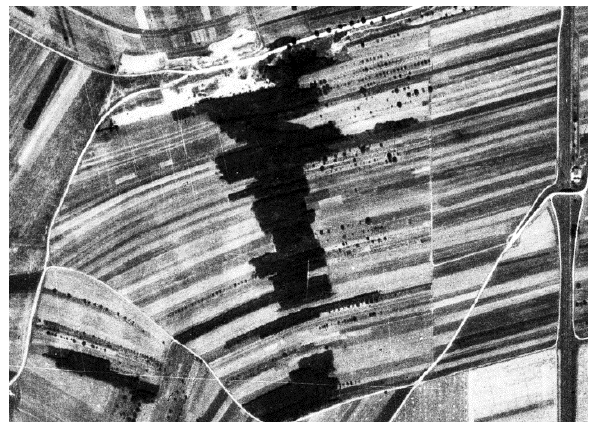
Figure 3. The result of Histogram Equalization The vector data of polygon categories made it possible to measure the total expanse of greenery, the expanse of individual green areas, the perimeter of individual green areas, and the shape of the areas using the Formula 1 in both periods.